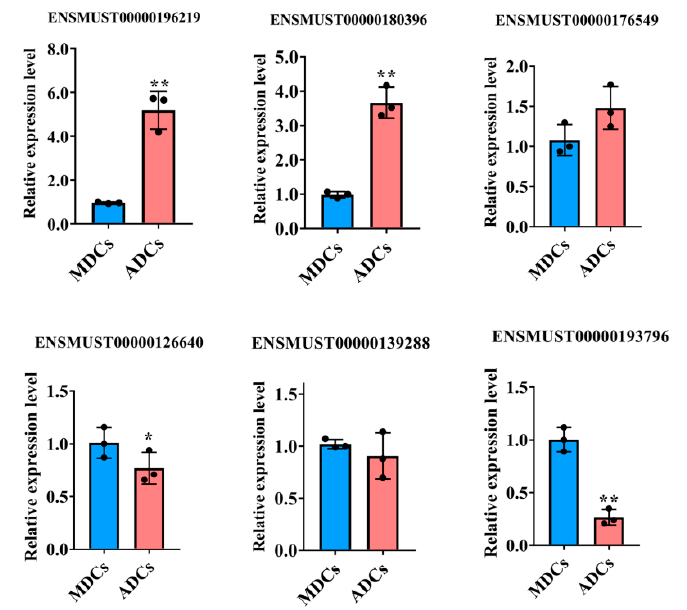
Figure 4. qPCR validation of the RNA-Sequencing (RNA-Seq) expression results of lncRNAs (six differentially expressed genes). The data are presented as the means ± SEM. n = 3, ** P ≤ 0.01, * P ≤ 0.05, Student’s t -test.